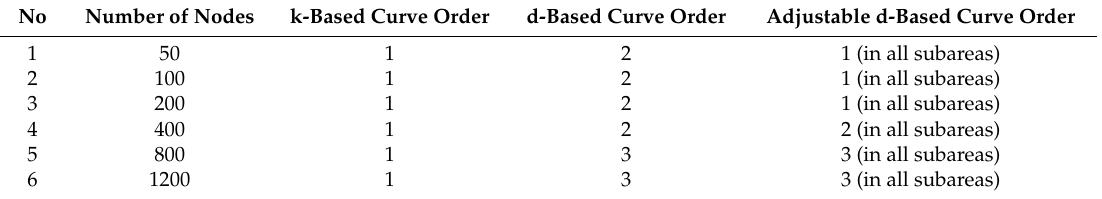
Table 3. The curve order of k-based, d-based and adjustable d based curve for different number of nodes. No Number of Nodes k-Based Curve Order d-Based Curve Order